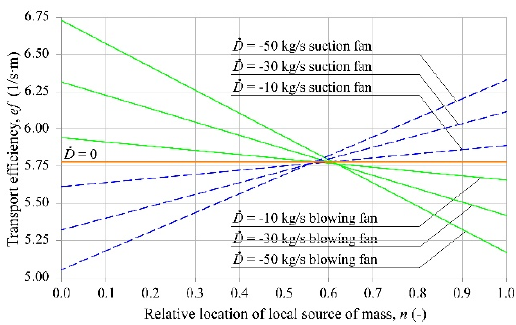
Figure 6. Duct gas transport efficiency in the presence of a local sink of mass.